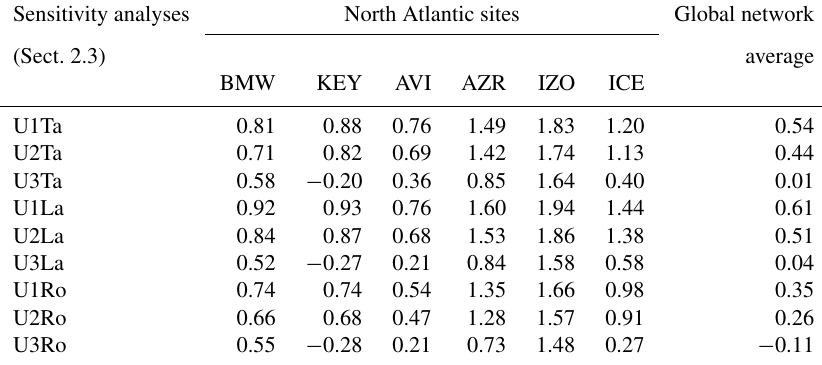
Table A2. Model–observation mismatch in atmospheric CO 2 concentrations (unit: ppm) at North Atlantic sites (average over year 2003). GCL model values are derived from the a posteriori model analyses associated with the sensitivity analyses of Sect. 3.1. Atmospheric CO 2 observations are from the NOAA GLOBALVIEW network described in Sect. 2.3. Note AVI ( − 64 . 75 ◦ , 17.76 ◦ ), site name: St. Croix, Virgin Islands. No observation is available during 2000–2017. Here the observations from the nearest site RPB ( − 59 . 43 ◦ , 13.17 ◦ ) for 2003 are